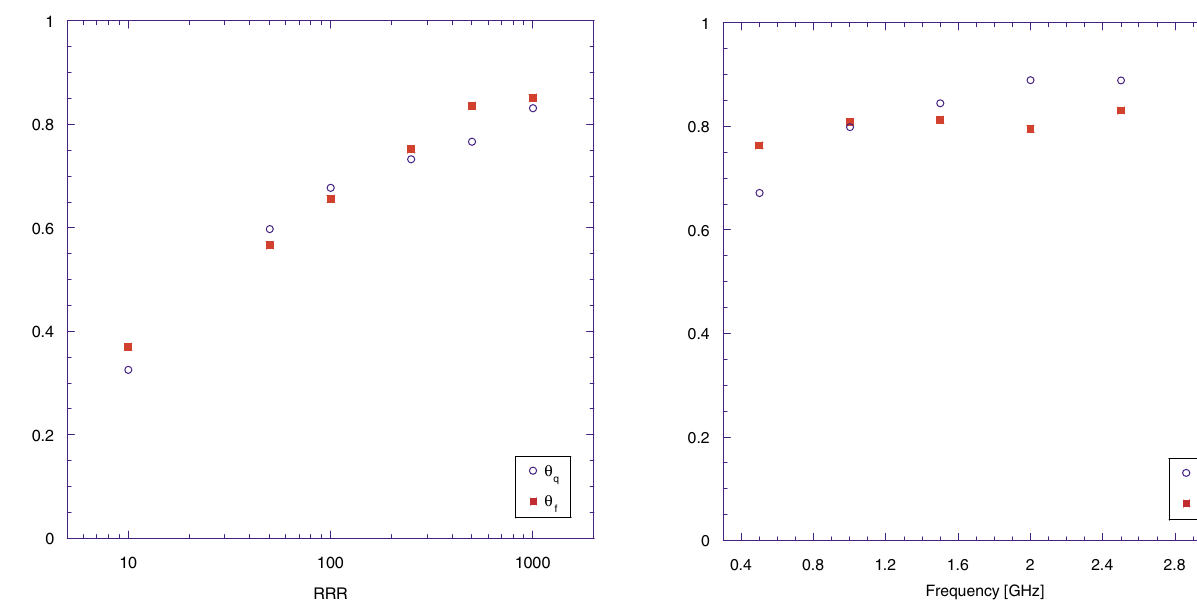
FIG. 12. (Color) Relative performance parameters as a func- tion of the cavity frequency. Bulk Nb cavity, 2 mm thick, RRR (cid:3) 300 , three pipes cooling.